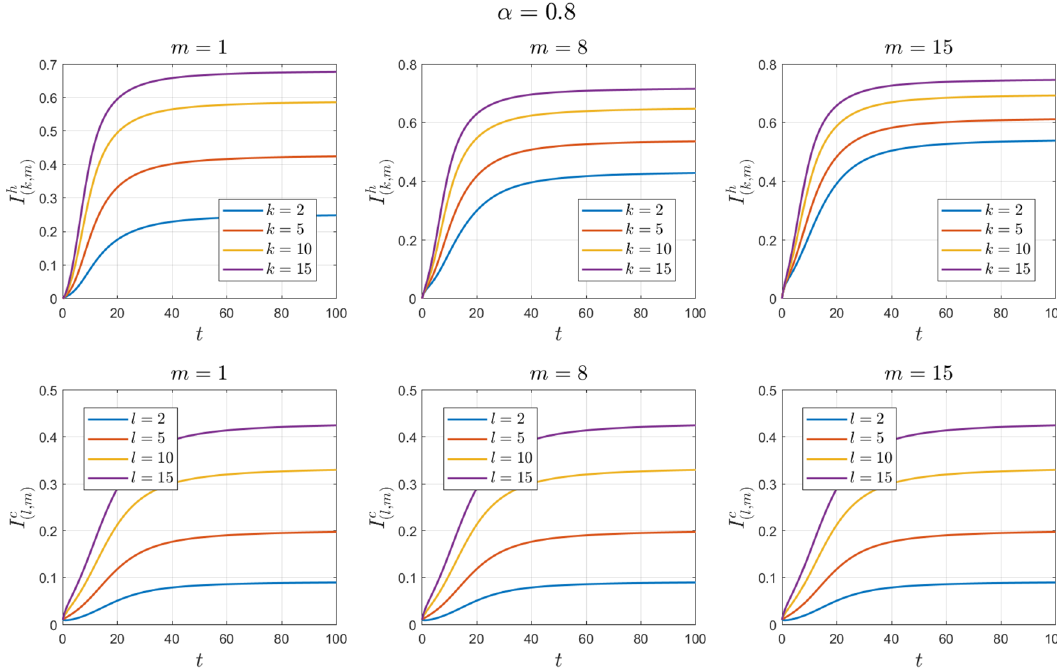
Figure 4. Numerical solutions of Example 2 for α = 0.8 .